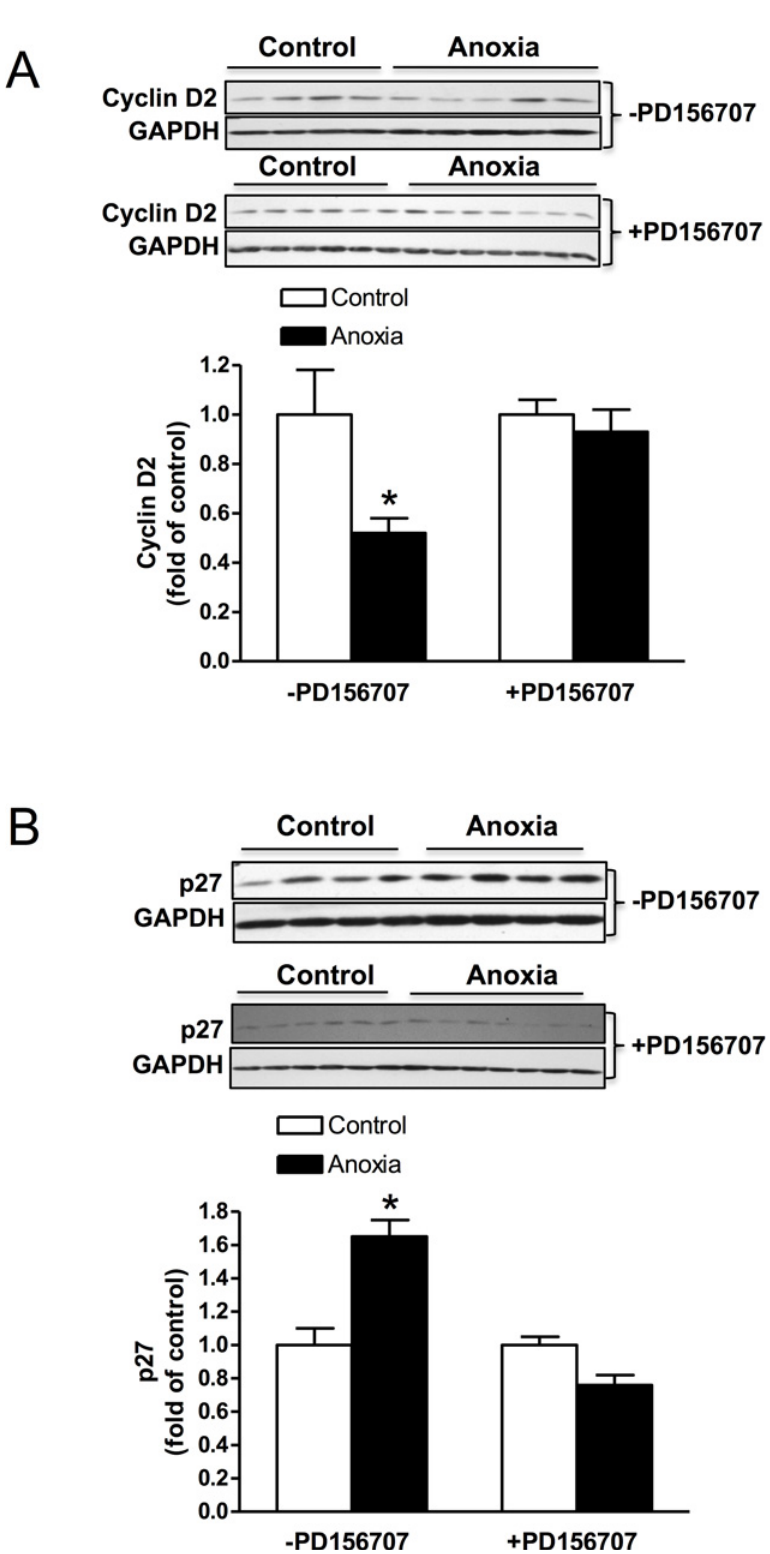
Fig 4. Effect of newborn anoxia on cyclin D2 and p27 protein expression in the cardiomyocyte. Hearts were isolated from day 4 neonatal rats treated with control or anoxia in the presence (n = 6 – 7) or absence (n